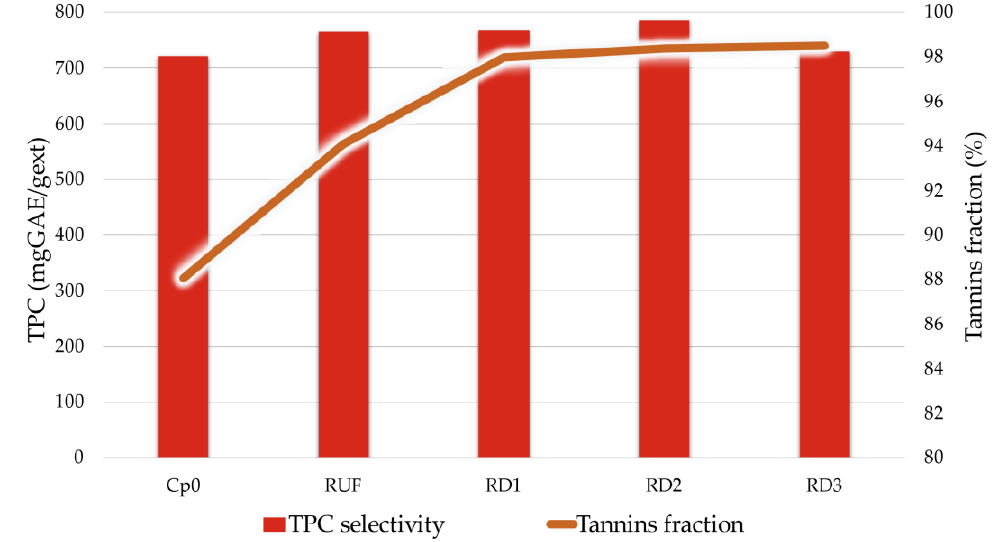
Figure 7. Tannin enrichment with the triple diafiltration (UF).